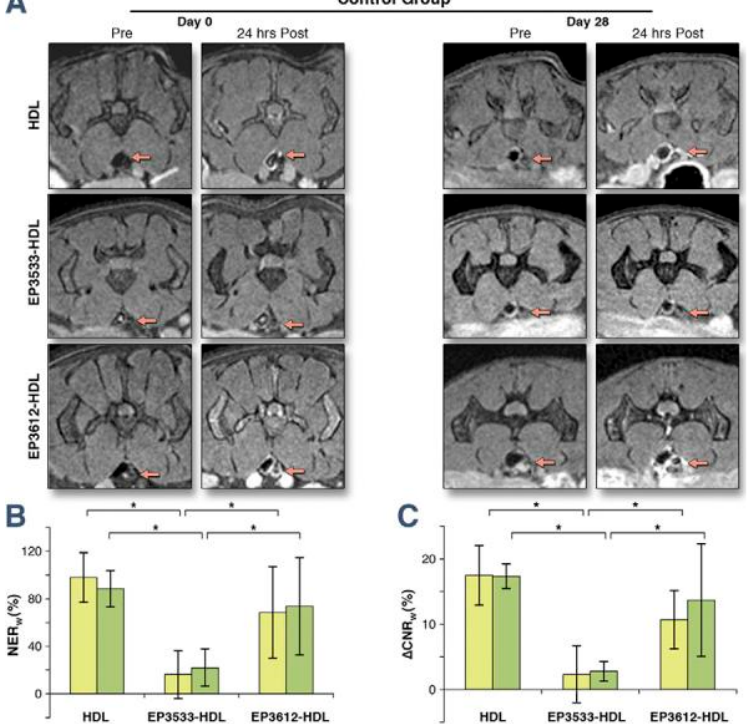
Figure 9. ( A ) Typical MR images, ( B ) normalised enhancement ratio of the aortic wall to muscle (NER w ) and ( C ) the difference between the contrast-to-noise ratio from the aortic wall to muscle pre- and post-contrast injection of abdominal atherosclerotic plaques for pre- and 24 h post-injection ( ∆ CNR w ) of HDL, EP3533-HDL, and EP3612-HDL at day 0 (yellow bars) and day 28 (green bars) of Reversa mice in the regression group. The red arrows point to the aortas. Error bars are representing mean ± SD. Statistical significance at p < 0.05 (n = 25) is indicated by the asterisks (*). HDL—high density lipoprotein. Reproduced with permission from Chen et al., 2013 [65].